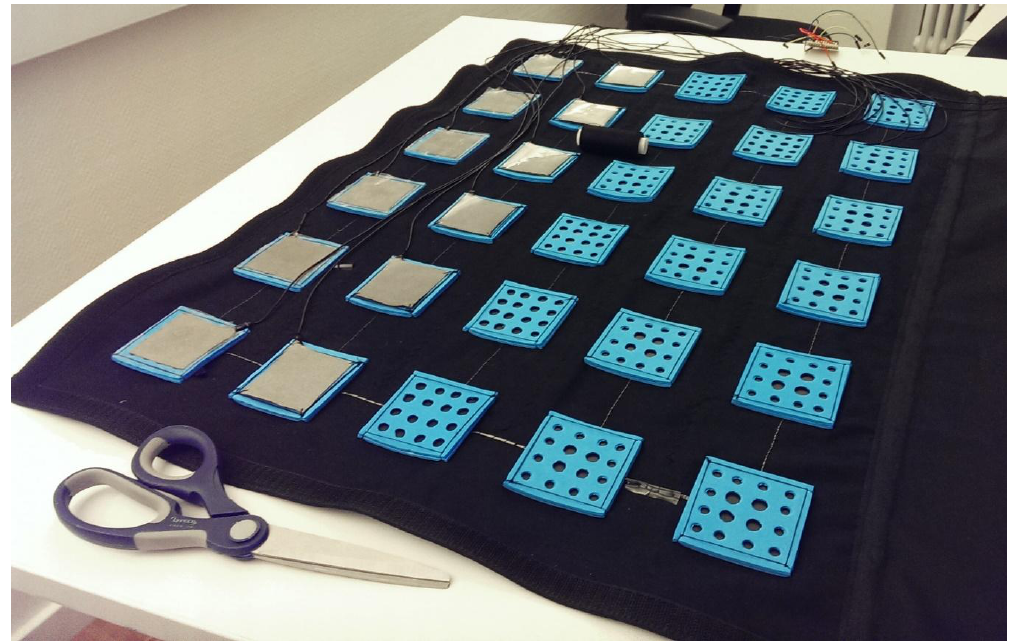
Figure 3. Prototype with flexible sensors.